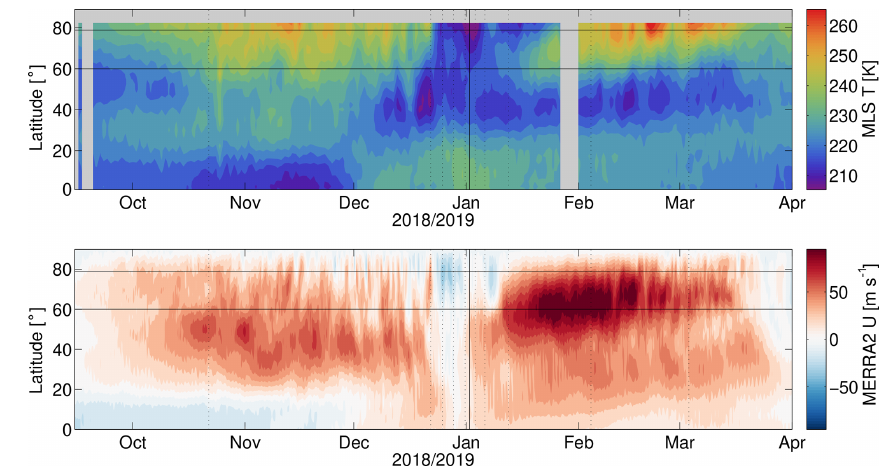
Figure 5. Same as in Fig. 4 but at 0.1hPa in the